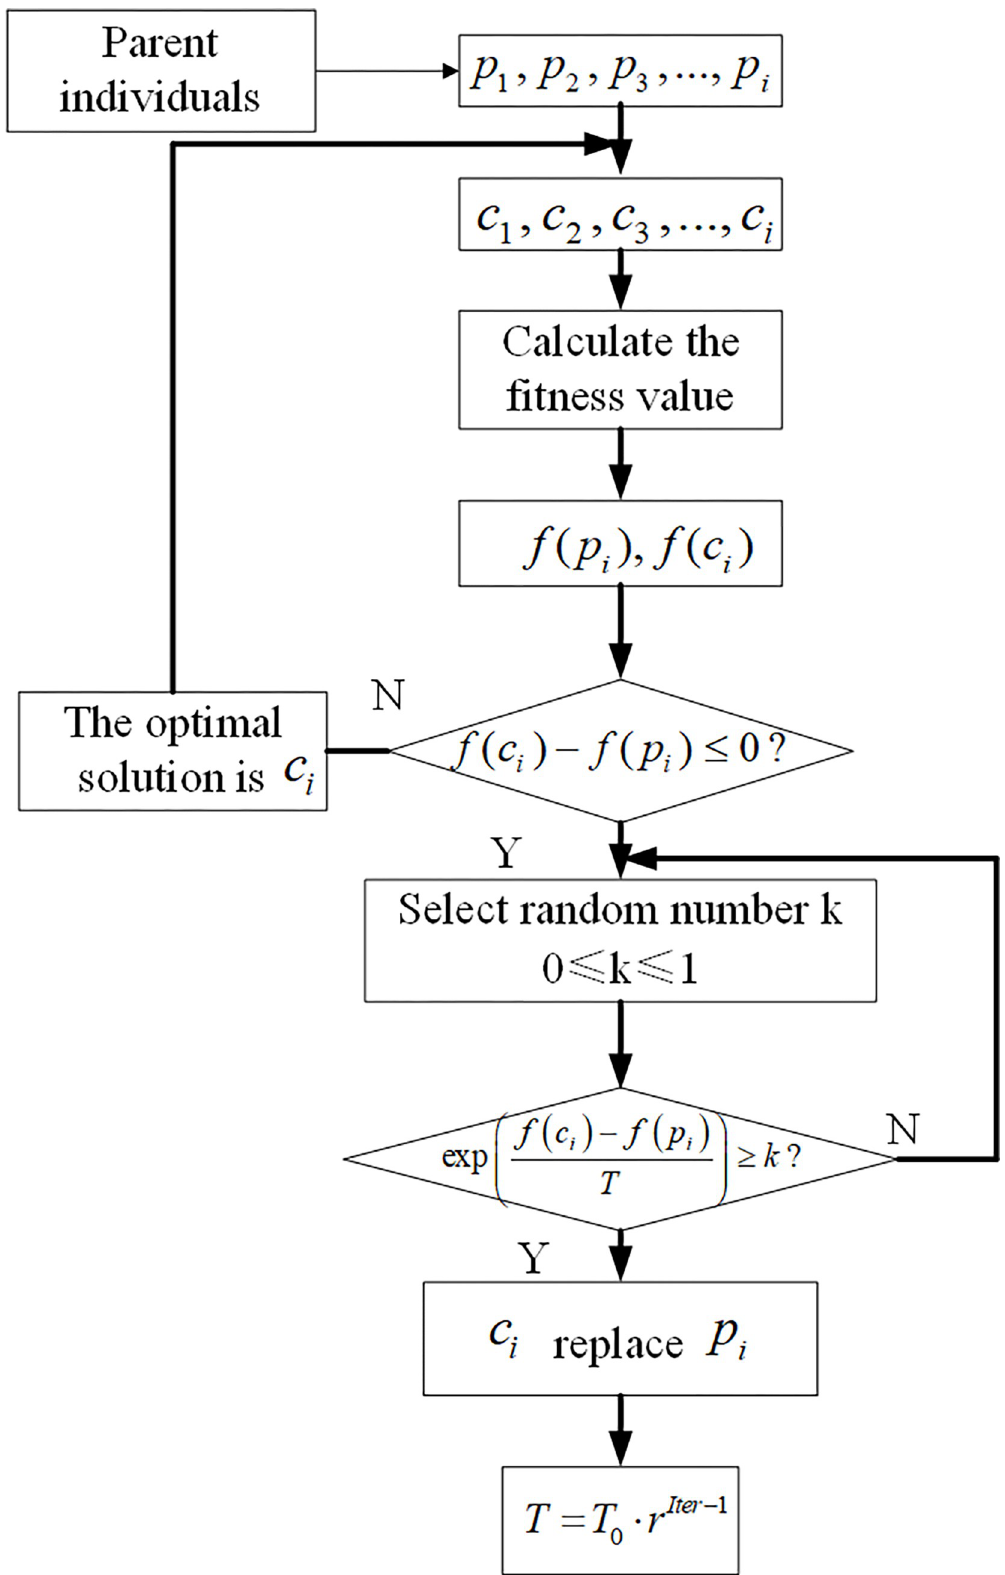
Fig 10. Simulated annealing operation